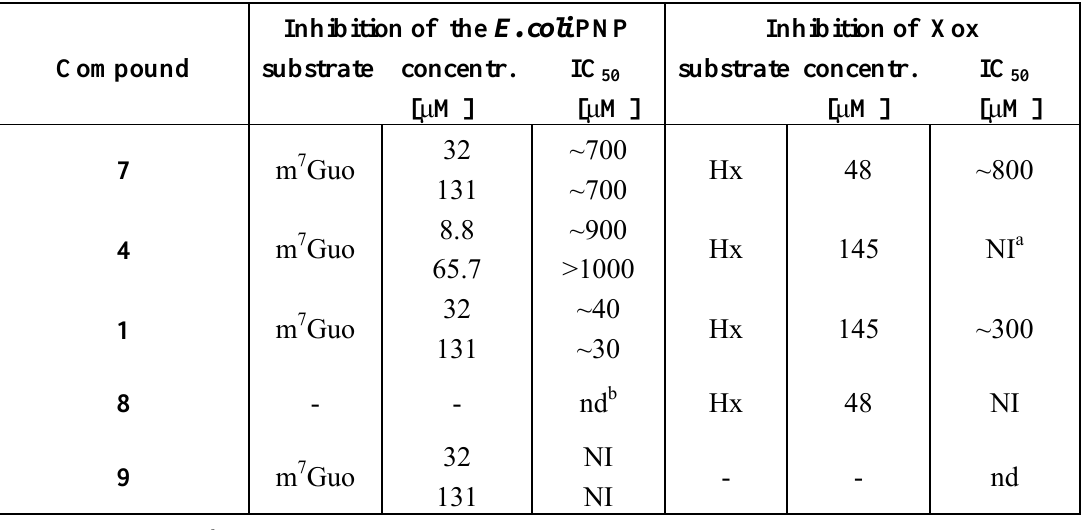
Table 2. Inhibition of bacterial ( E. coli ) purine-nucleoside phosphorylase and xanthine oxidase from buttermilk by the investigated pyrazolotrazines . Inhibition of Xox Inhibition of the E. coli PNP substrate Compound substrate concentr. IC 50 [ µ M] [ µ M]